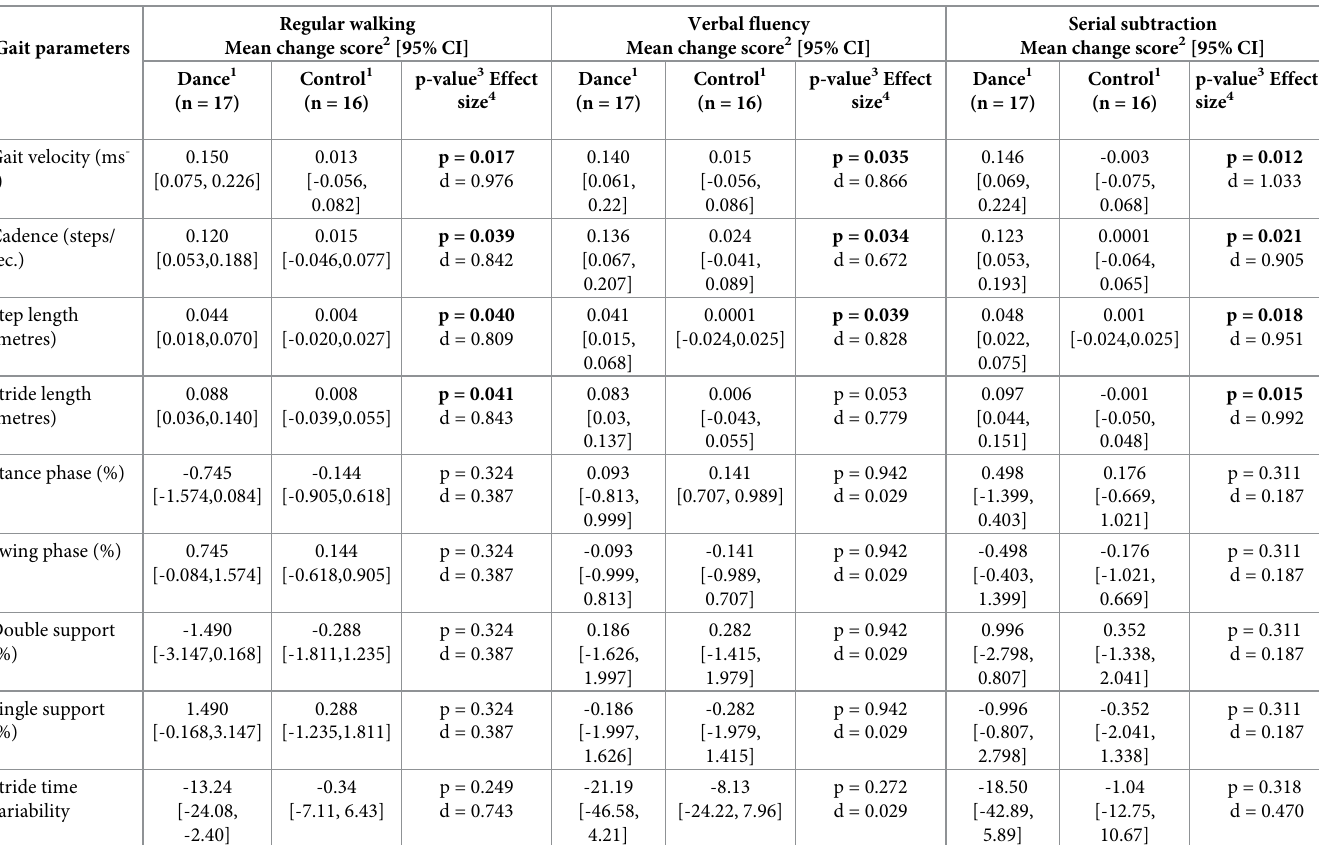
Table 3. Pre-post change score of the spatiotemporal parameters of gait during even surface walking without a secondary task, and with cognitive secondary